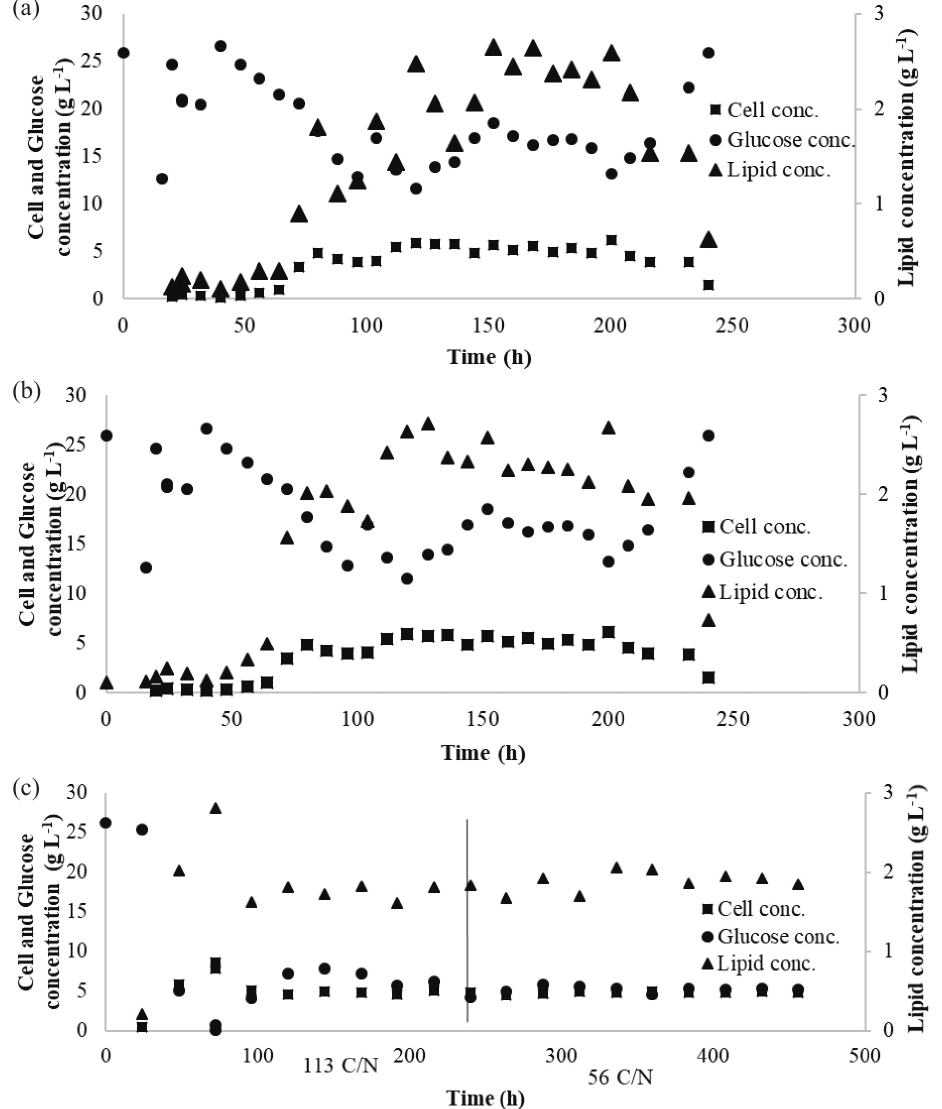
Fig. 5 – (a) Continuous cultivation of L. starkeyi at 0.06 h –1 dilution rate with C/N ratio of 113; (b) Continuous cultivation of L. starkeyi at 0.06 h –1 dilution rate with C/N ratio of 56; (c) Continuous cultivation of L. starkeyi at 0.02 h –1 dilution rate with C/N ratio of 113 and 56,